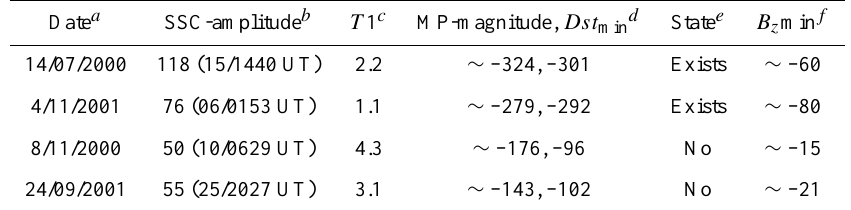
Table 1. The storm sudden commencement amplitude, main phase duration and main phase magnitude presented in the table are as deter- mined from Alibag observatory records. Order of events is according to decreasing order of main phase magnitude for all cases. All the magnetic field measurements are given in nano Tesla